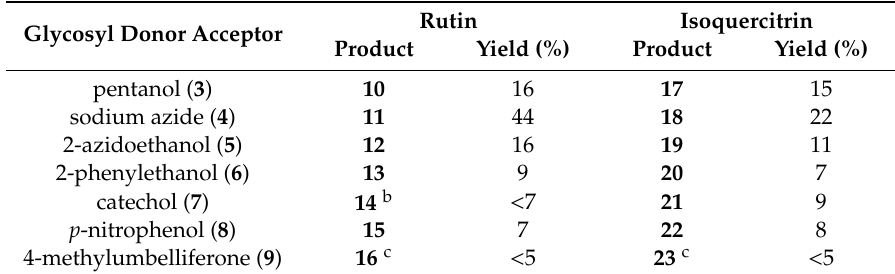
Table 1. Typical isolated yields of transglycosylation products a .